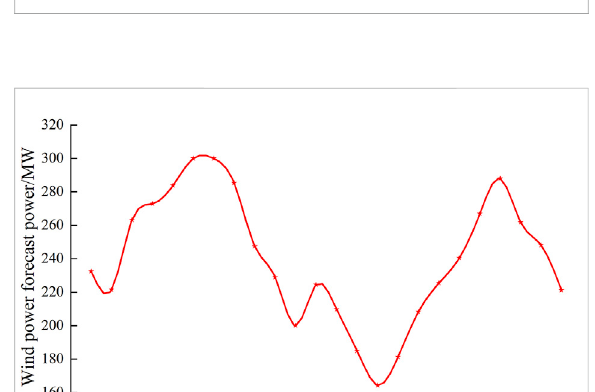
FIGURE 6 Electric load prediction power.